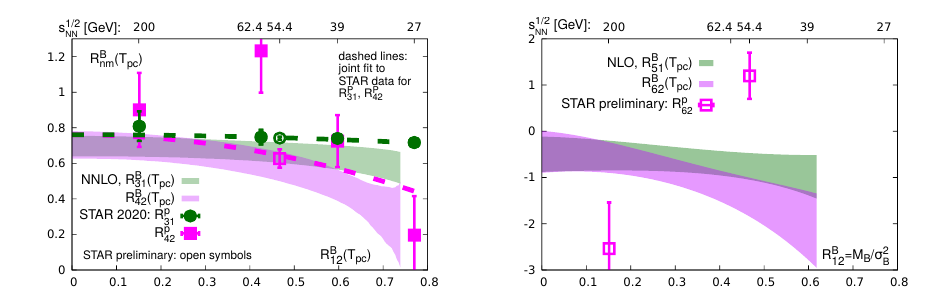
B / M ( T ,µ B ) = S B σ 3 ( T ,µ B ) = κ B σ 2 as a function B and R B B 31 42 ( T ,µ B ) and R B ( T ,µ B ) as a function of R B ( T ,µ B ) in 12 51 62